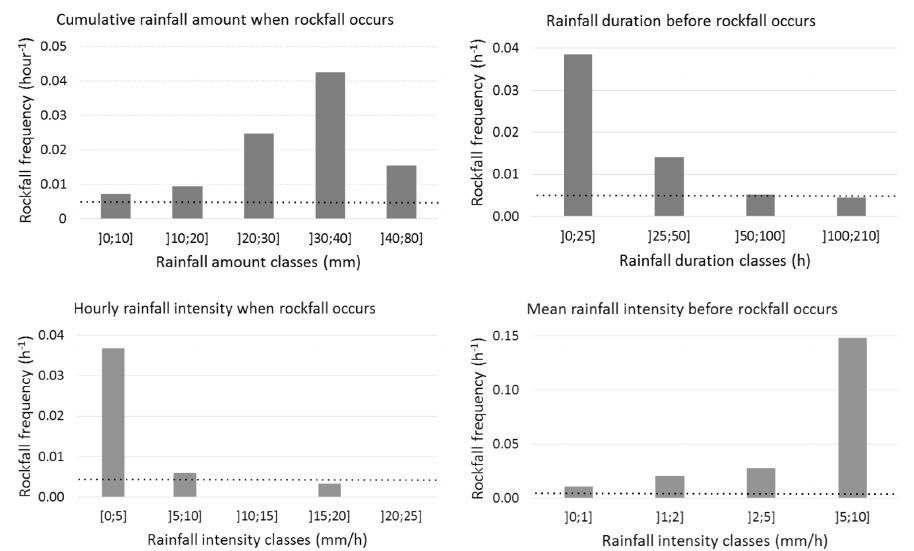
Figure 9. Rockfall frequency for different rainfall amount, rainfall duration and rainfall intensity. Dashed black lines show rockfall frequency without meteorological perturbations.